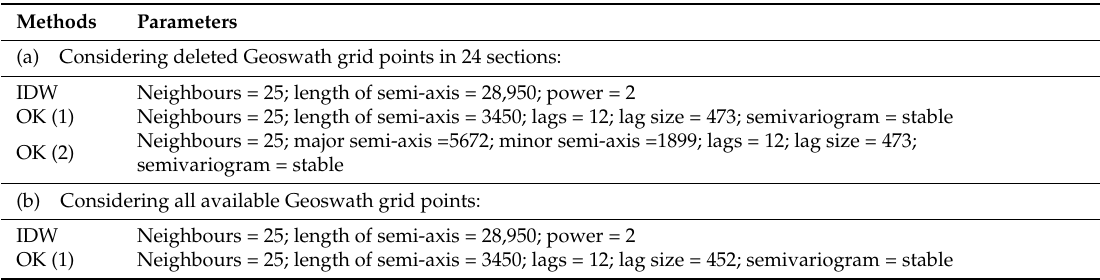
Table 3. Parameters used in the spatial interpolation methods.